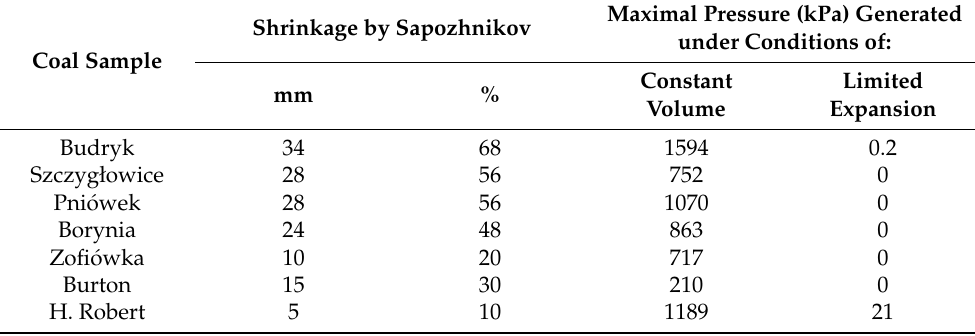
Table 6. Comparison of the coking pressure generated by the plastic layer during carbonization under conditions of the limited expansion (corresponding to the coke shrinkage of the examined coals) and under conditions of the constant volume of the carbonized sample).